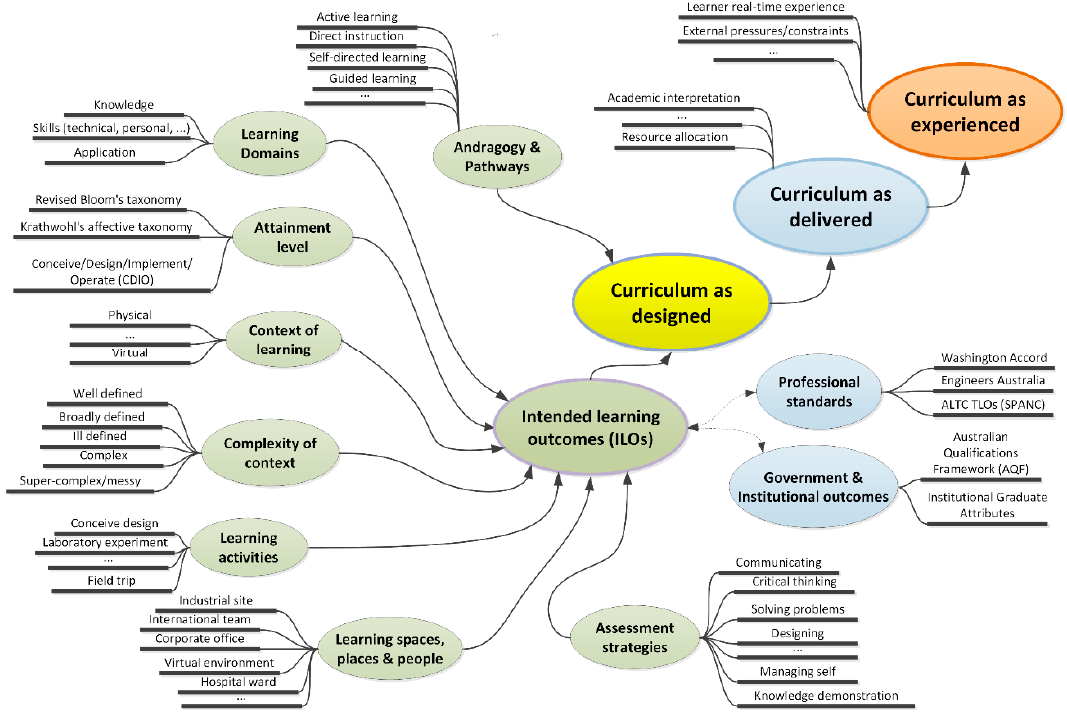
Figure 3. Curriculum design building blocks and information.